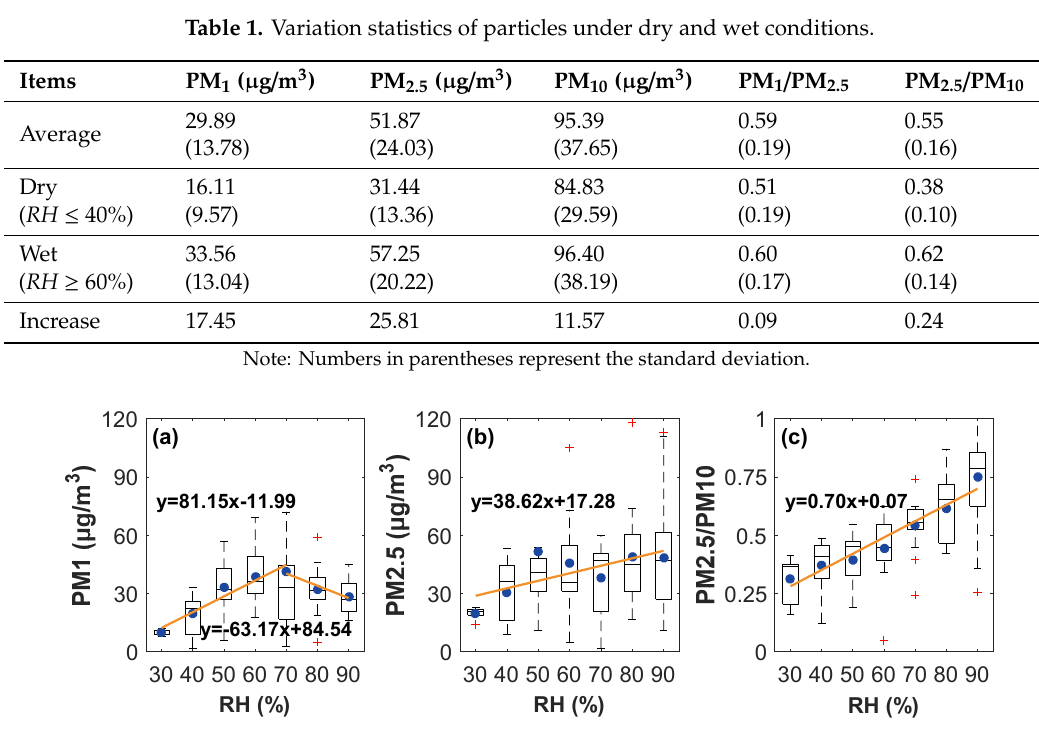
Figure 1. Variation in ( a ) PM 1 , ( b ) PM 2.5 and ( c ) mass fraction of PM 2.5 in PM 10 with increasing RH during winter.